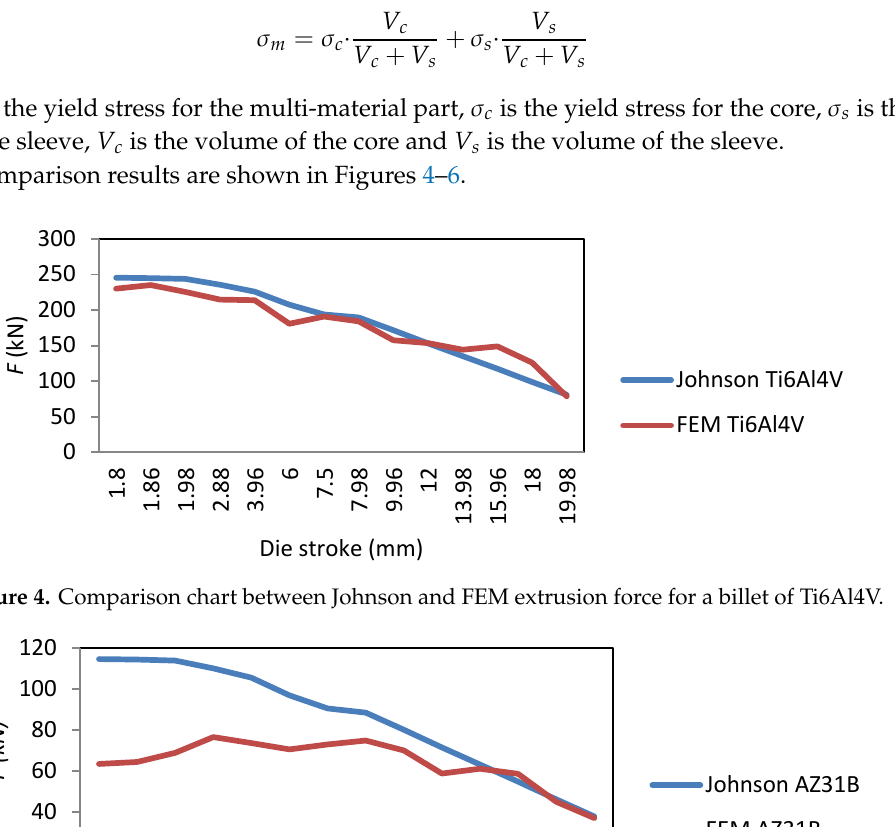
Figure 6. Comparison chart between Johnson and FEM extrusion force for a multi-material billet. After comparing the analytical results with the simulation ones, it can be concluded that the FE model is robust enough to be validated. 2.4. Design of Experiments (DOE) Once the FE model has been validated, the next step is to define the design of experiment (DOE) methodology [28] to identify and quantify the parameters with a higher influence in the extrusion force and the damage induced in the multi-material extrudate. In Figure 7, an Ishikawa chart is shown in order to list the possible causes that may affect the extrusion force; where H 0 is the initial height of the billet, D 0 is the initial external diameter of the sleeve and d 0 is the initial diameter of the core. Figure 7. Ishikawa’s chart for the analysis of the bimetallic extrusion process.